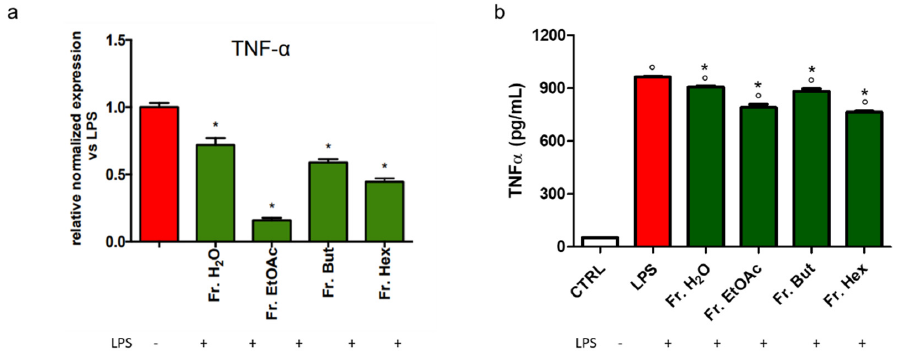
Figure 12. Gene expression and protein content of TNF- α in BV-2 cells treated with different chestnut leaf extract fractions. BV-2 cells were treated for 3 h with 50 µ g/mL of different leaf-derived extract fractions, then stimulated with 0.5 µ g/mL LPS for a total of 24 h. ( a ) At the end of incubation, RNA was extracted from cells and samples were subjected to RT-PCR analysis using a specific primer for TNF- α , as explained in the Materials and Methods section. The relative mRNA contents were normalised to LPS-treated cells (red bars). Relative quantification is obtained as described in the Materials and Methods section ( b ) Cellular content of TNF- α was quantified by ELISA assay as described in the Materials and Methods section. Results are expressed as means ± SEM of three independent experiments. Statistical analysis was performed by Fisher’s LSD test following one-way ANOVA. ◦ p < 0.05 significantly different from control cells; * p < 0.05 significantly different from LPS-treated